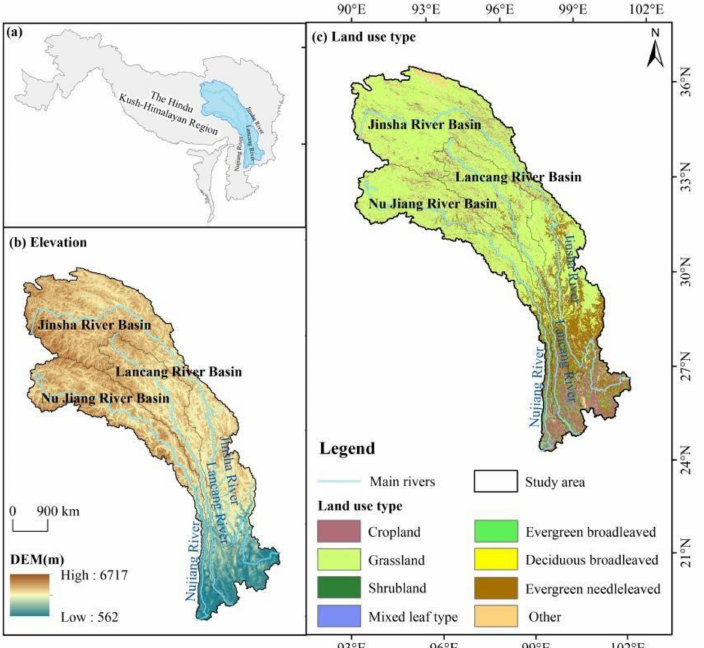
Figure 1. The location elevation and vegetation type maps of the study area. ( a ) the location of TPRR at the eastern part of Hindu-Kush-Himalayan Region; ( b ) Elevation gradients across the TPRR; ( c ) the vegetation types of